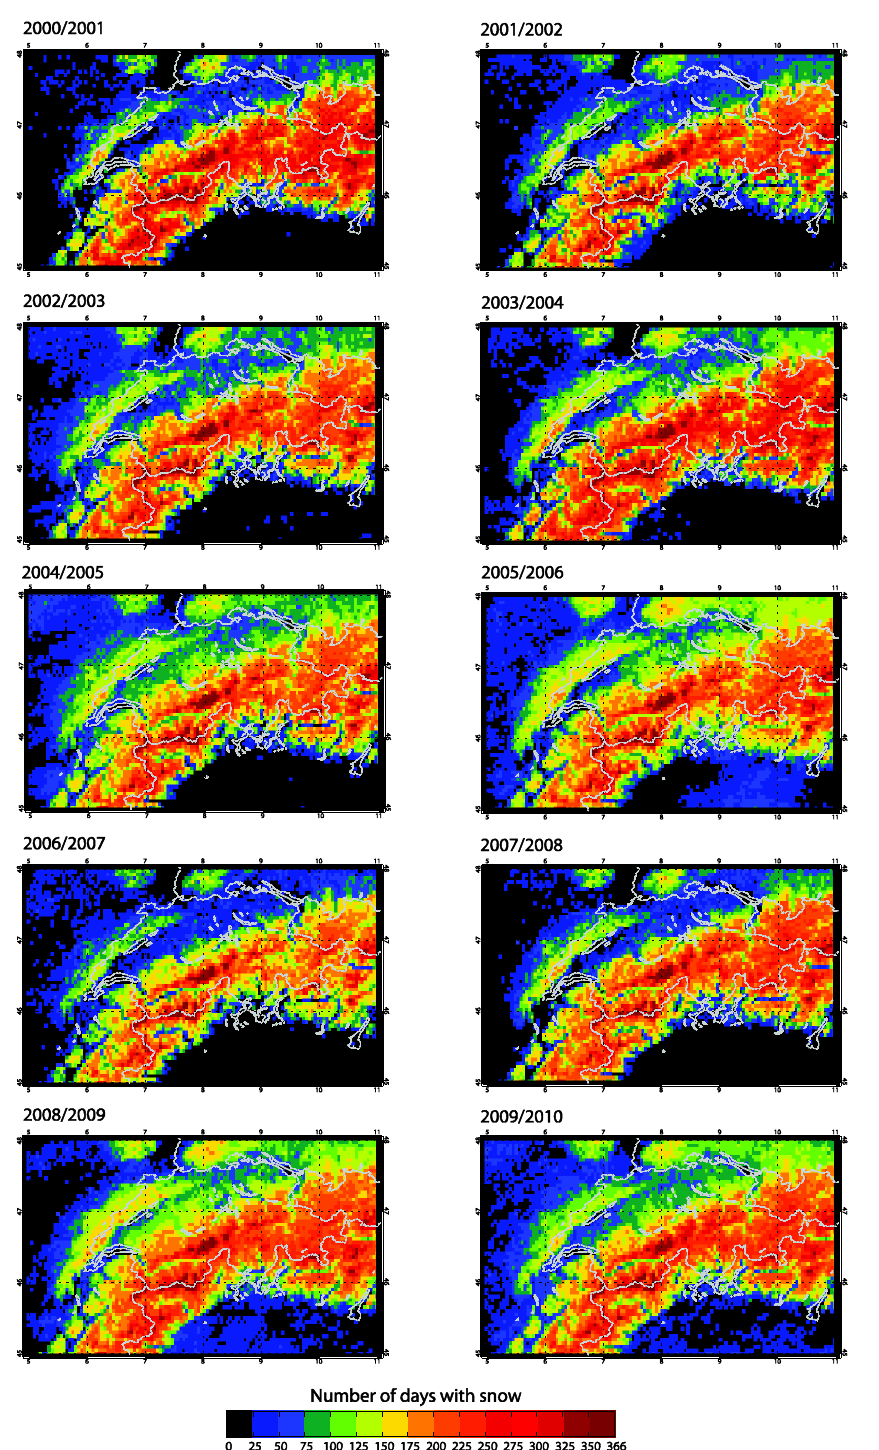
Fig. 1. Satellite-derived number of days with snow per year over Switzerland from 2000 to 2010.